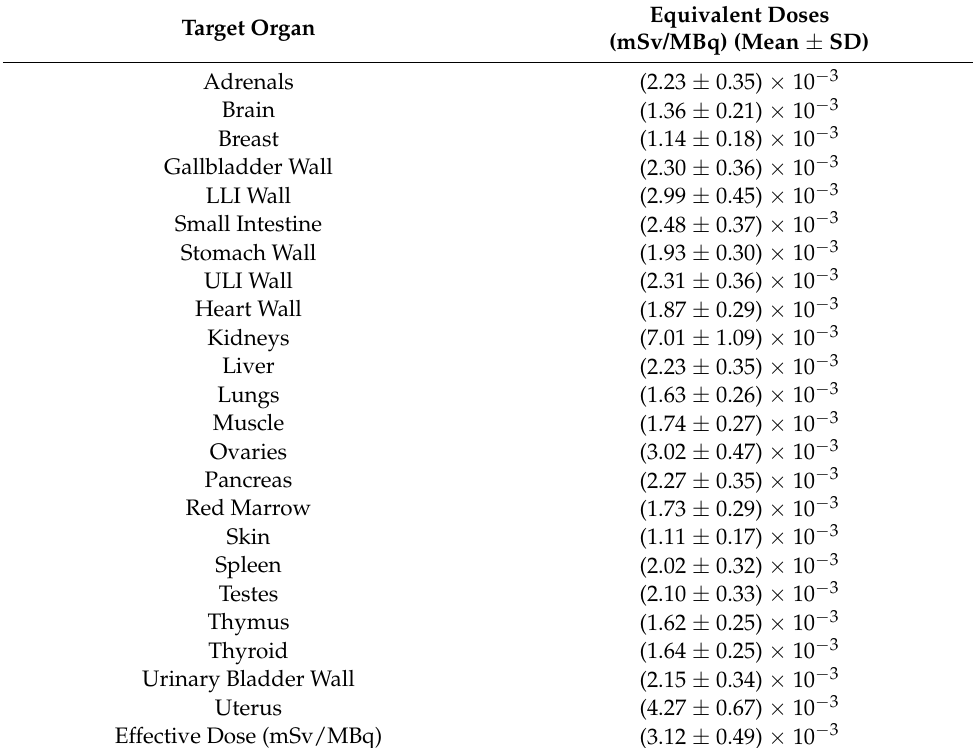
Table 2. Equivalent and effective doses of [ 99m Tc]Tc-iFAP obtained from six healthy subjects (1 female and 5 males).